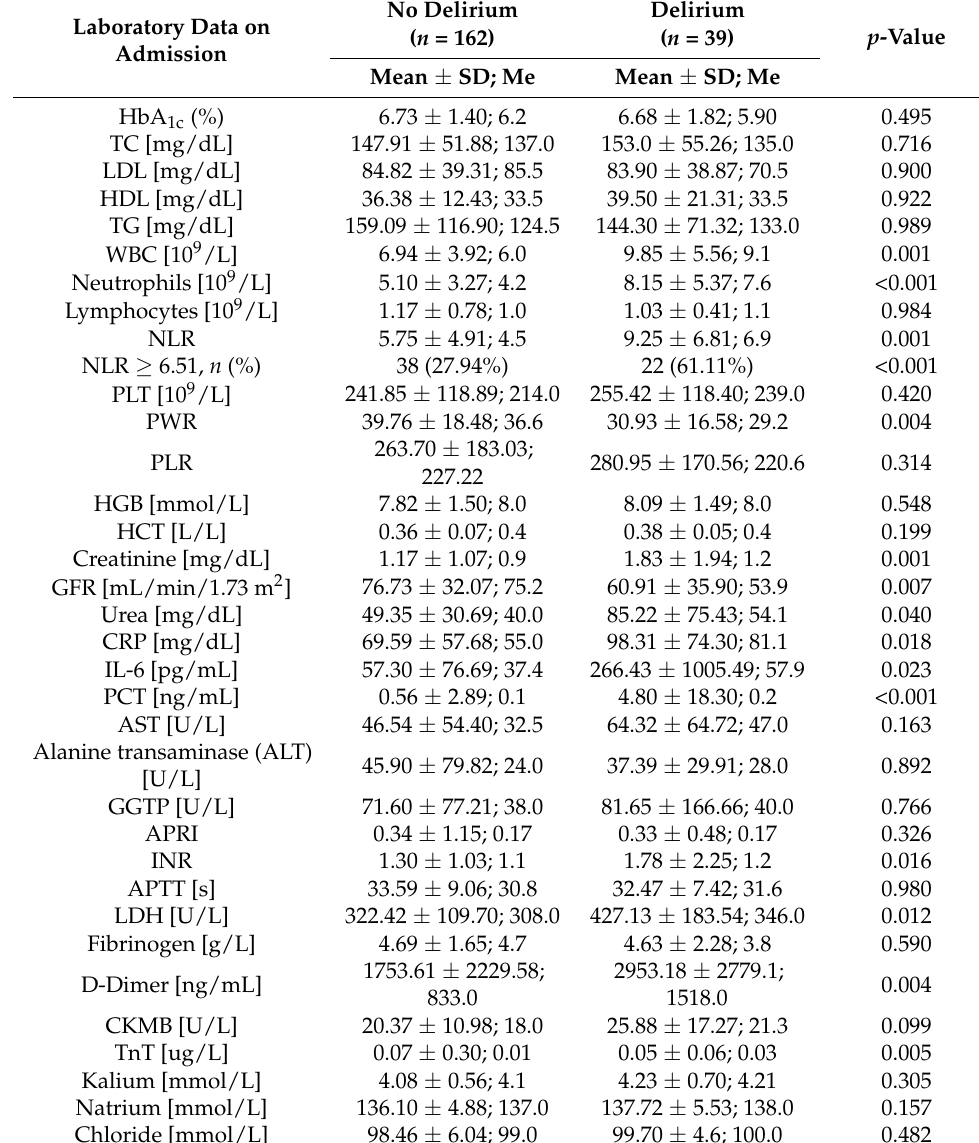
Table 4. Laboratory results on